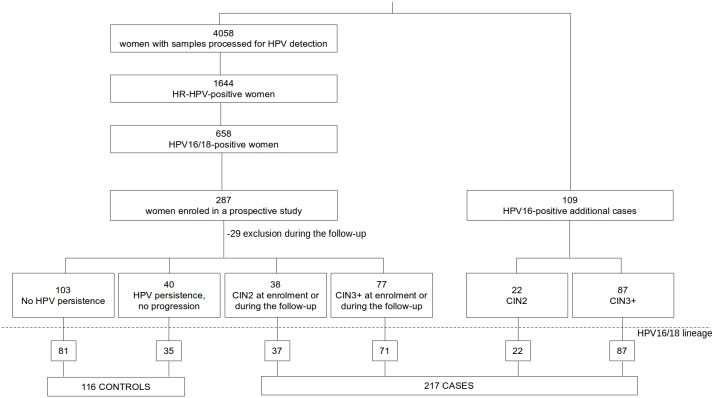
Study population.CIN2: Cervical intraepithelial neoplasia grade 2. CIN3+ includes CIN grade 3-carcinoma in
situ, invasive squamous cell carcinoma, adenocarcinoma in
situ, and adenocarcinoma. Controls for the analysis were women without progression to CIN2 or CIN3+ during the two-year follow-up of the prospective study of HPV16/18-positive women. Cases were women with histological diagnosis of HPV16/18-positive CIN2 or CIN3+ at enrolment or during the two-year follow-up of the prospective study. Enrolment of the prospective study: from 2009 to 2010. Additional cases were HPV16-positive CIN2 or CIN3+ cases collected from 2006 to 2008 and 2011 to 2012.